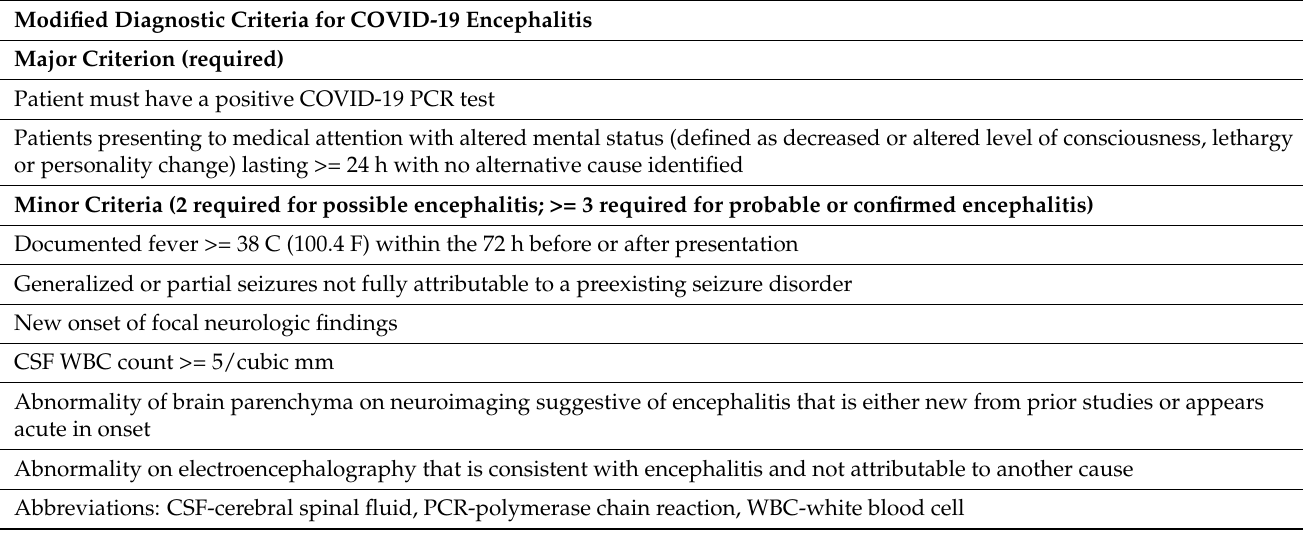
Table 1. Modified Diagnostic Criteria for COVID-19 Encephalitis [13].